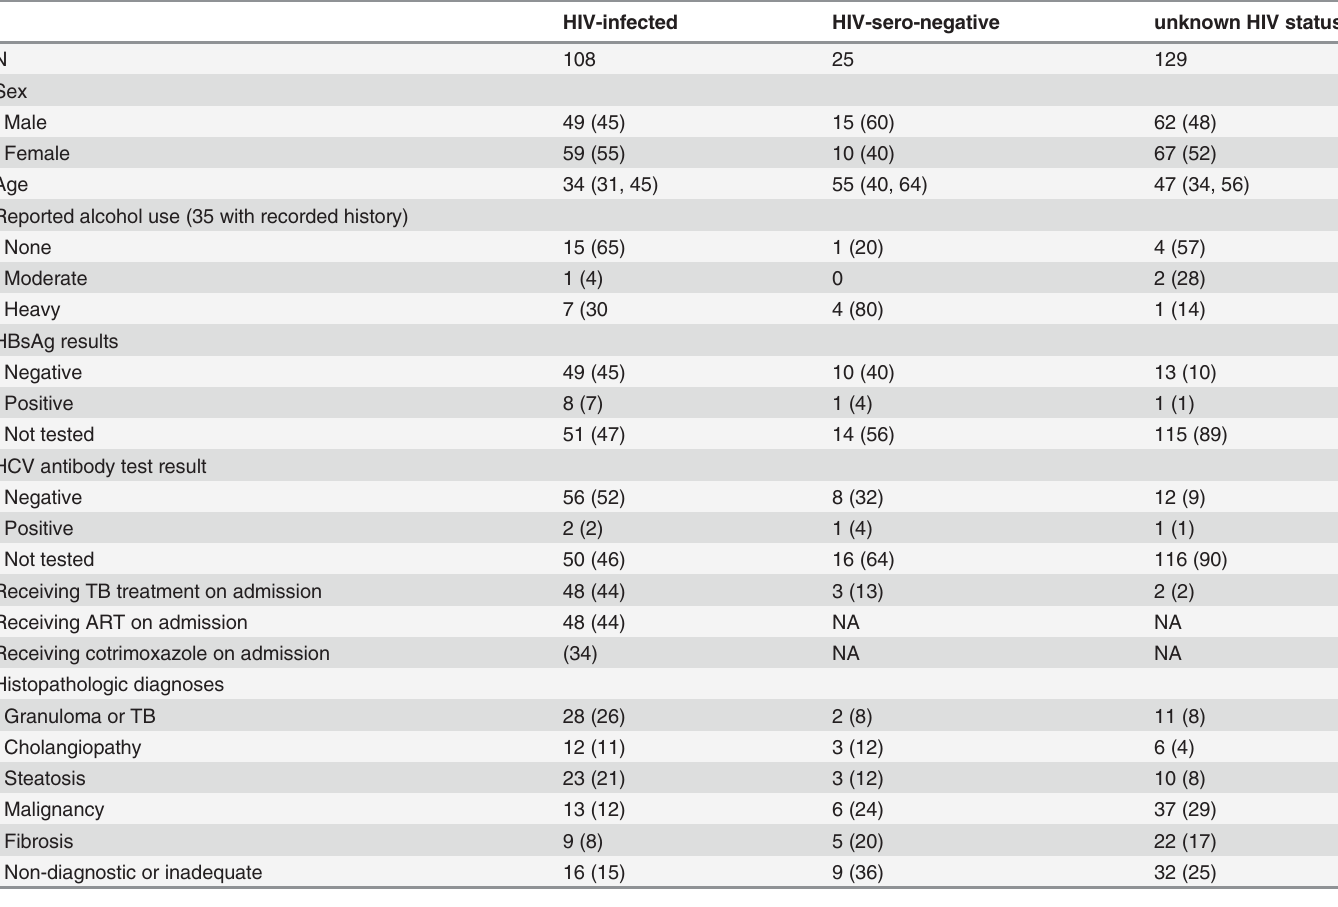
Table 1. Patient characteristics.